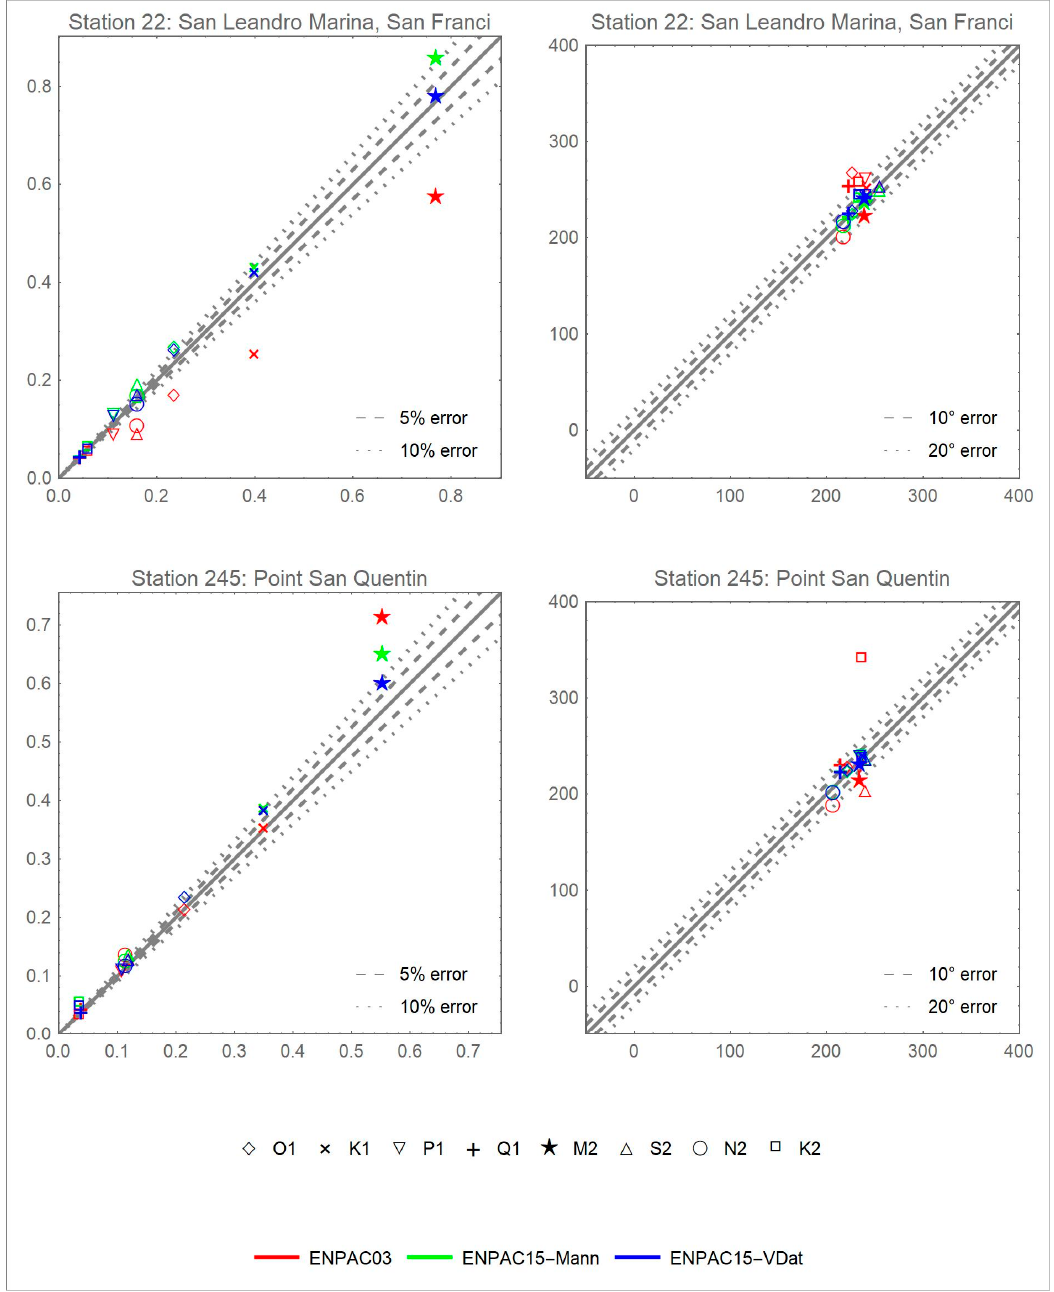
Figure A7. Scatterplots of errors for two San Francisco Bay stations, locations shown in Figure A2.